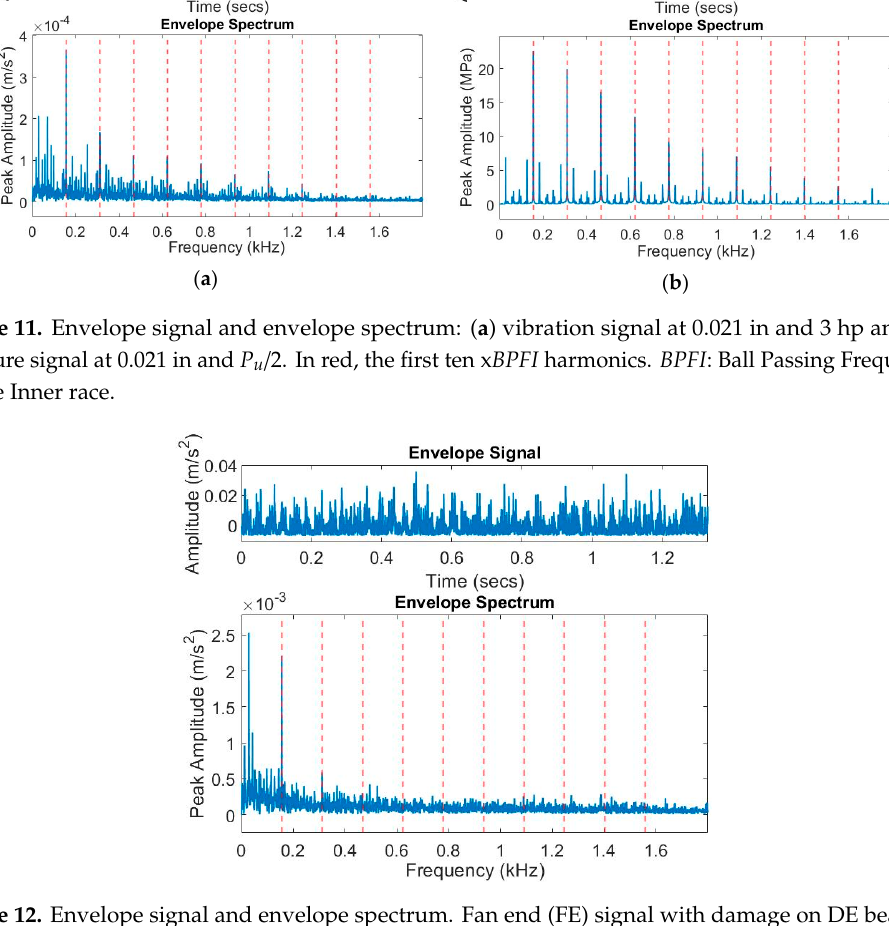
Figure 10. Kurtograms: pressure signals. The three columns refer, respectively, to 0.007, 0.014 and 0.021 in. The three rows refer, respectively, to P u /8, P u /4 and P u /2. Once signals were band pass-filtered in the frequency bands suggested by SK, the envelope analysis was applied. The modulus of the analytic signal was then investigated in the frequency domain (Figure 11). The x BPFI harmonic contributions were particularly examined. Unlike raw spectra, x BPFI harmonics were fairly identifiable even in the FE signal (Figure 12).